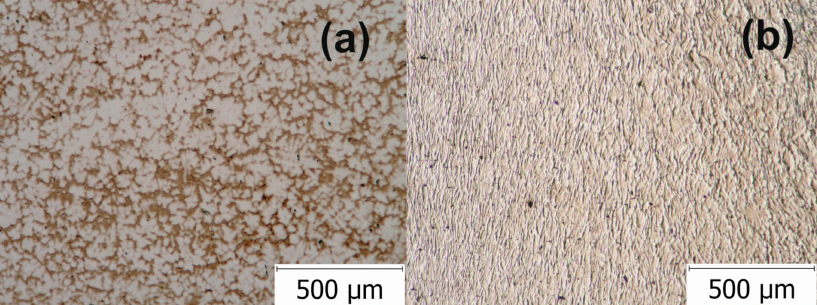
Figure 1. Optical microscopy images showing the microstructure of the Ti-Nb-Zr-Ta-Fe-O alloy in the: ( a ) as-cast and ( b ) high speed high pressure torsion (HSHPT) processed states.